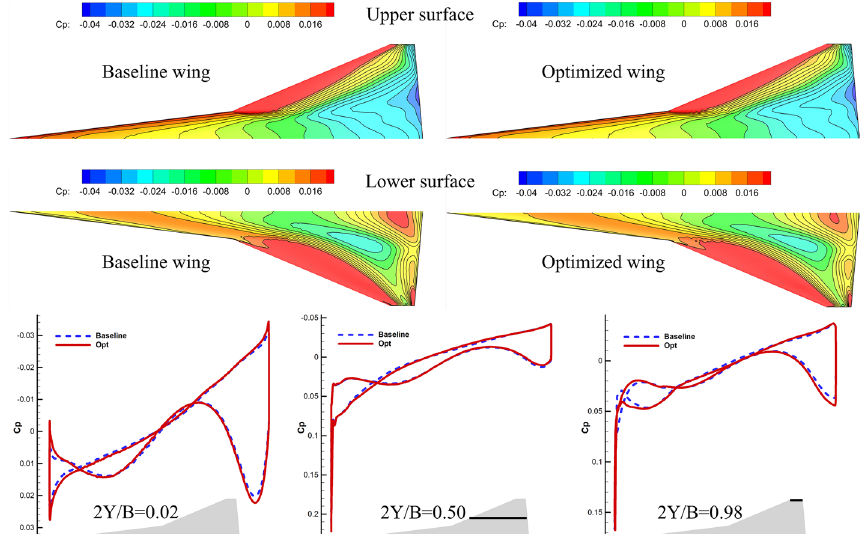
Fig. 33 Comparison of pressure coefficient contours and sectional pressure coefficient distributions at three wing spanwise locations using baselines and optimized profiles (optimization case 3)